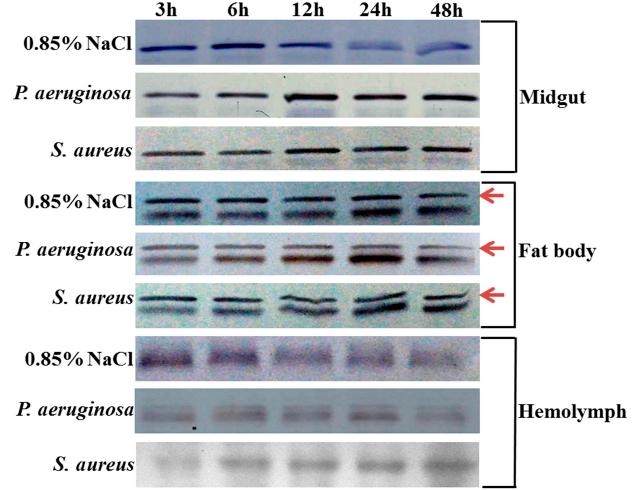
Figure 6. Protein expression profiles of ScFerHCH in the midgut, fat body and hemolymph post challenging by P. aeruginosa (Pa) and S. aureus (Sa) at 3, 6, 12, 24 and 48 h. Sterile 0.85% NaCl was used as a control. The red arrows indicated target band.